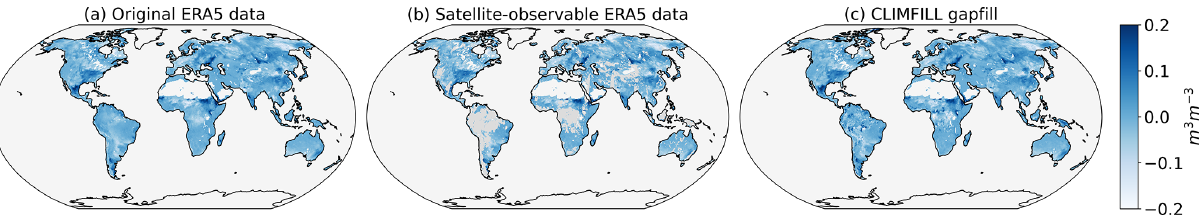
Figure 4. Comparison of (a) the original naturally gap-free ERA-5 reanalysis, (b) the same data but where only satellite-observable values are shown, and (c) the gap-filled data created from CLIMFILL after starting with the gappy data in (b) . The maps show an example snapshot of ERA-5 surface-layer soil moisture anomaly on 1 August 2020. CLIMFILL successfully reconstructs major anomalies in surface-layer soil moisture for this day. The anomalies are calculated by subtracting the monthly mean values.